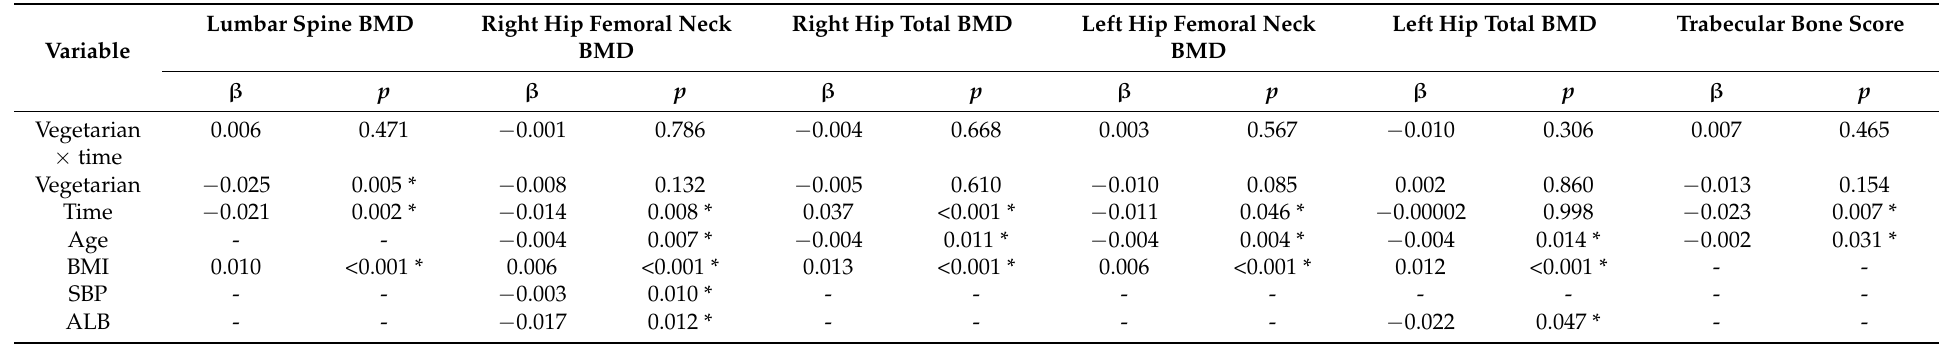
Table 4. Results of generalized estimating equations for the effects of a vegetarian dietary habit on the change in BMD and trabecular bone score over time in female patients aged 65–90 years ( n = 247).